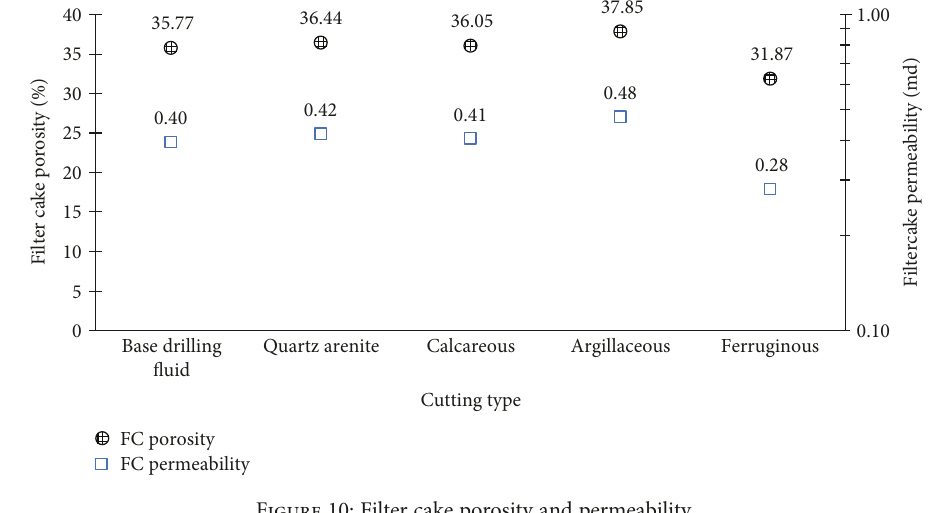
Figure 10: Filter cake porosity and permeability. Table 4: Solubility for di ff erent types of sandstone cuttings. Experiment